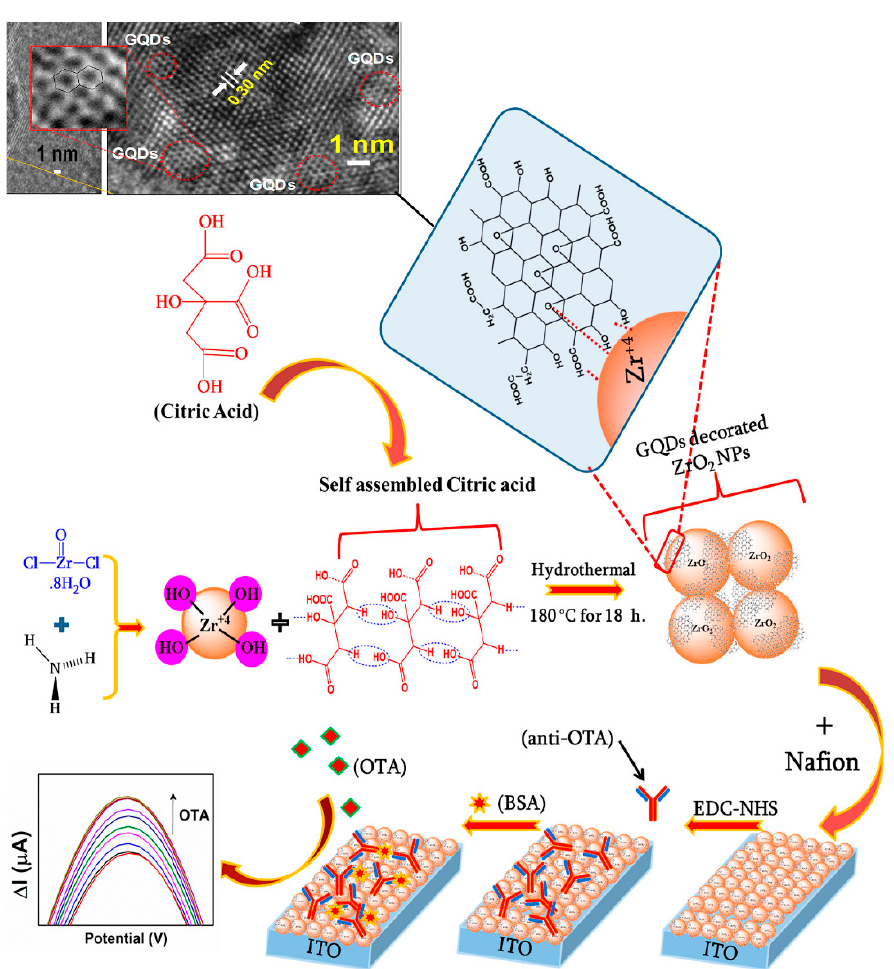
Figure 7. Detection of ochratoxin-A by electrochemical biosensing on (GQDs@ZrO 2 ) electrodes. (Adapted with the permission of Ref. [124]).